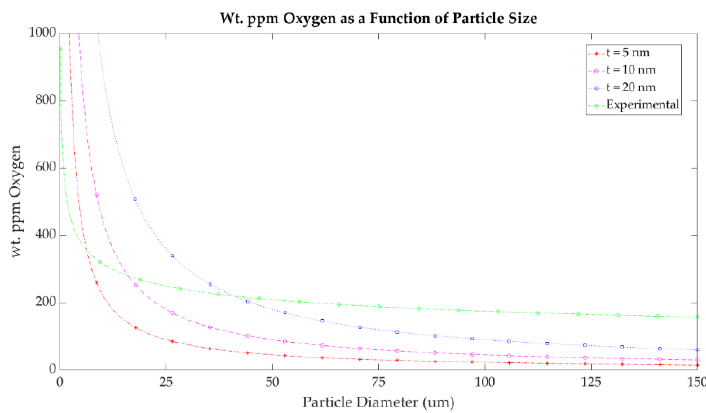
Figure 19. Wt. ppm oxygen as a function of the particle size, assuming a 5 nm cuprous oxide film.